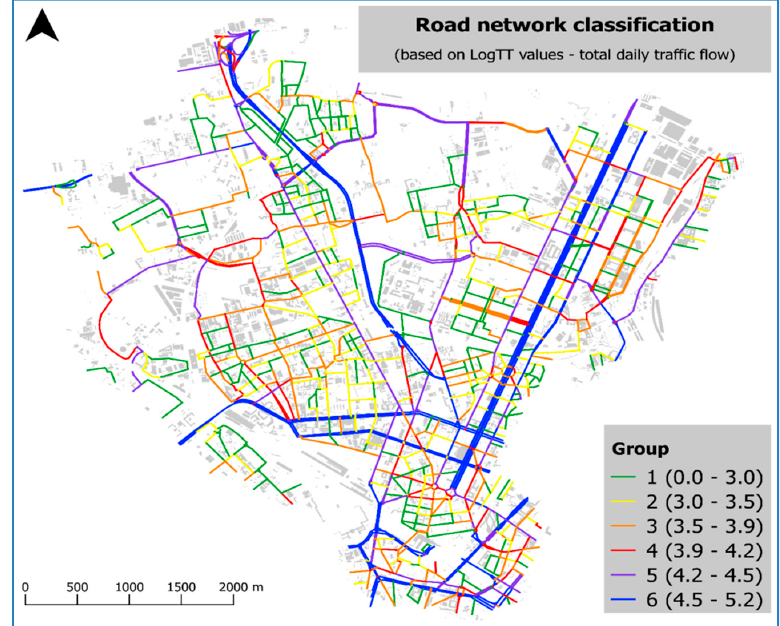
Figure 6. The six groups of road stretches (different colors) for the actual implementation of Dynamap. In the inset we report the intervals of x values within each group.